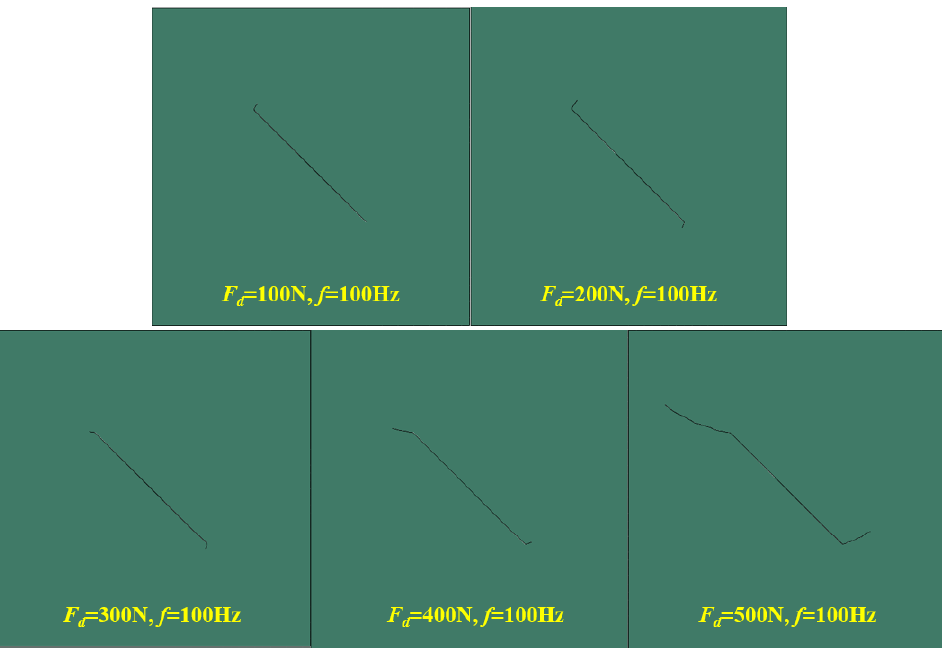
Figure 13. Schematic diagram of crack initiation under different amplitudes of dynamic load.